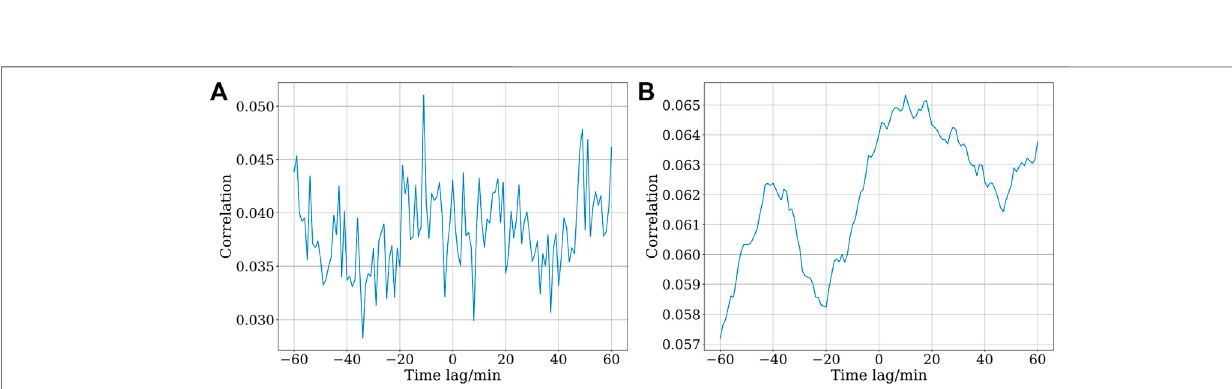
FIGURE A1 | Autocorrelation of price returns. The fi rst-order autocorrelation of mid-quote price returns is signi fi cantly smaller than that of volume-weighted price returns, indicating a smaller level of microstructure noise in mid-quote price returns. Con fi dence interval.